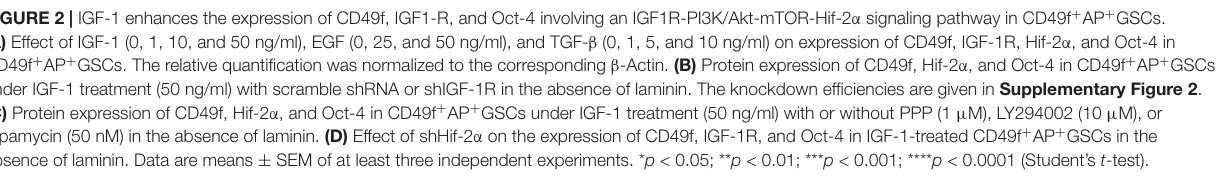
FIGURE 2 | IGF-1 enhances the expression of CD49f, IGF1-R, and Oct-4 involving an IGF1R-PI3K/Akt-mTOR-Hif-2 α signaling pathway in CD49f + AP + GSCs. (A) Effect of IGF-1 (0, 1, 10, and 50 ng/ml), EGF (0, 25, and 50 ng/ml), and TGF- β (0, 1, 5, and 10 ng/ml) on expression of CD49f, IGF-1R, Hif-2 α , and Oct-4 in CD49f + AP + GSCs. The relative quantification was normalized to the corresponding β -Actin. (B) Protein expression of CD49f, Hif-2 α , and Oct-4 in CD49f + AP + GSCs under IGF-1 treatment (50 ng/ml) with scramble shRNA or shIGF-1R in the absence of laminin. The knockdown efficiencies are given in Supplementary Figure 2 . (C) Protein expression of CD49f, Hif-2 α , and Oct-4 in CD49f + AP + GSCs under IGF-1 treatment (50 ng/ml) with or without PPP (1 µ M), LY294002 (10 µ M), or rapamycin (50 nM) in the absence of laminin. (D) Effect of shHif-2 α on the expression of CD49f, IGF-1R, and Oct-4 in IGF-1-treated CD49f + AP + GSCs in the absence of laminin. Data are means ± SEM of at least three independent experiments. * p < 0.05; ** p < 0.01; *** p < 0.001; **** p < 0.0001 (Student’s t